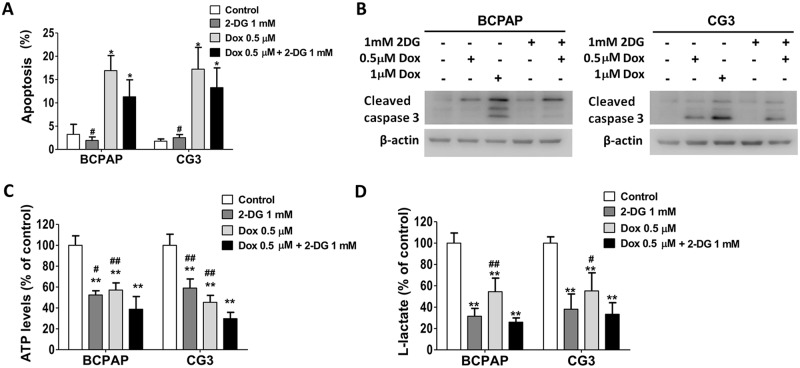
Effects of 2-DG, doxorubicin, or both on apoptosis and metabolic dysfunction in PTC cells.(A) The effect of 2-DG, doxorubicin, or both on apoptosis in BCPAP and CG3 cells. The two cell lines were cultured in medium supplemented with 10% fetal bovine serum and then treated for 48 h with 1 mM 2-DG, 0.5 μM doxorubicin, or both. Apoptosis was examined using propidium iodide (PI)/annexin V staining and flow cytometry; PI−/annexin V+ cells were defined as apoptotic cells. (B) The expression of cleaved caspase 3 in BCPAP and CG3 cells treated for 48 h with 2-DG, doxorubicin, or both. (C) Intracellular ATP levels and (D) extracellular l-lactate production in cells treated for 48 h with 1 mM 2-DG, 0.5 μM doxorubicin, or both. *p < 0.05, **p < 0.001, compared to the controls (t test); #p < 0.05, ##p < 0.001, compared to 2-DG plus doxorubicin treatment (t test). Data are presented as means ± standard deviation (SD).